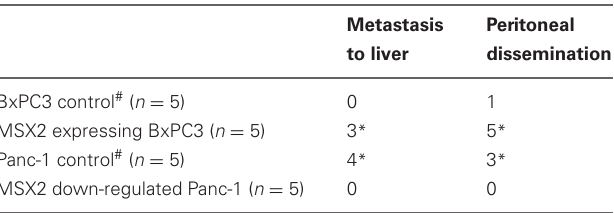
Table 3 | Summary of orthotopic implantation of MSX2-expressing or down-regulated cells in nude mice (Satoh et al.,